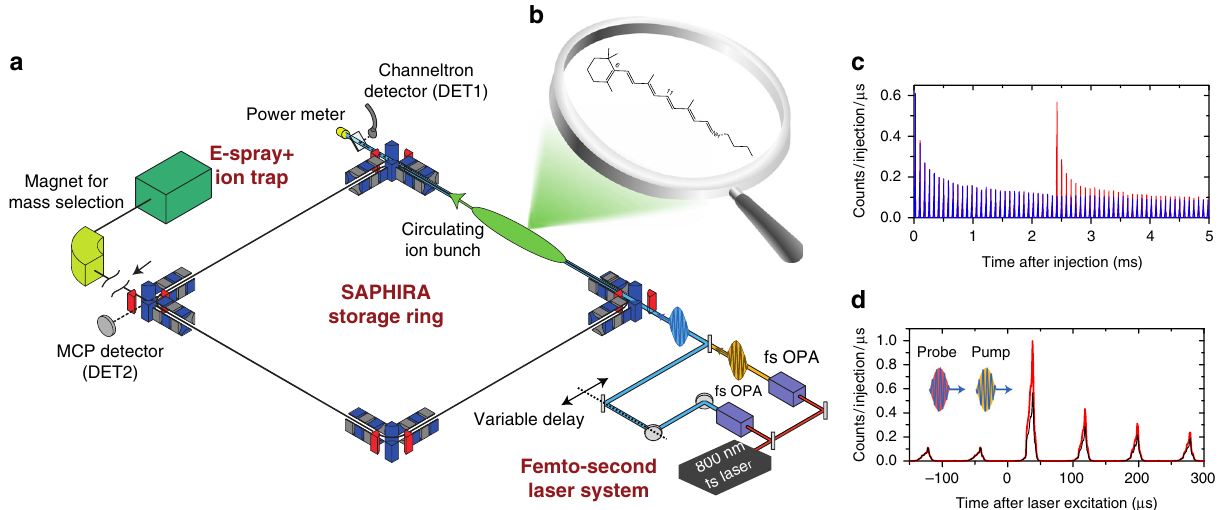
Fig. 1 Experimental technique. a The experimental setup at the electrostatic ion-storage ring SAPHIRA 38 . Ions are produced by electrospraying retinal chromphores dissolved in methanol. The chromophore ions are stored in SAPHIRA before being irradiated by femtosecond laser pulses. b The all- trans protonated Schiff-base retinal chromophore. c Circulating ions produce neutral fragments from collisions with the residual gas (blue curve). Absorption of photons (after 2.4 ms of ion storage) increases the internal energy and causes statistical fragmentation after internal conversion to the ground state, as measured by the micro-channel plate (MCP) detector (red curve) 39 . d At each pump-probe delay laser-induced fragmentation is registered as a function of storage time in SAPHIRA. The pump-probe signal is obtained by subtracting background contributions (collisional background as well as single-pulse events) from the total two-pulse signal (see Supplementary Figure